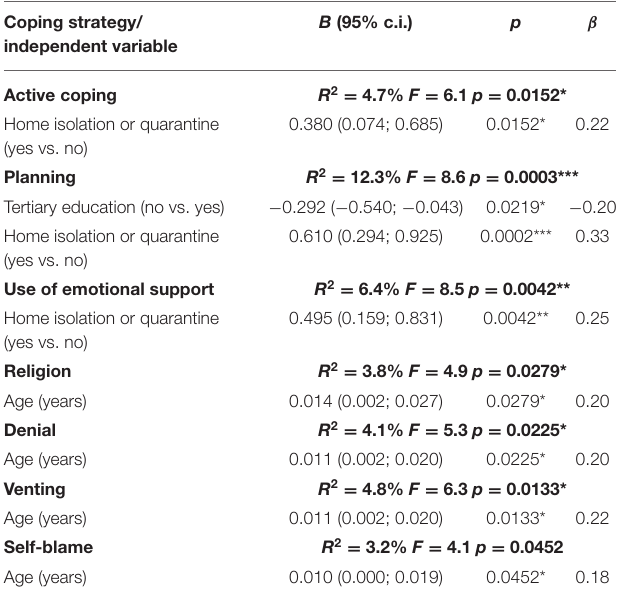
TABLE 6 | Coping strategies according to MiniCOPE among nurses in Belarus according to the COVID-19 pandemic elements and demographic factors. Coping strategy/ independent